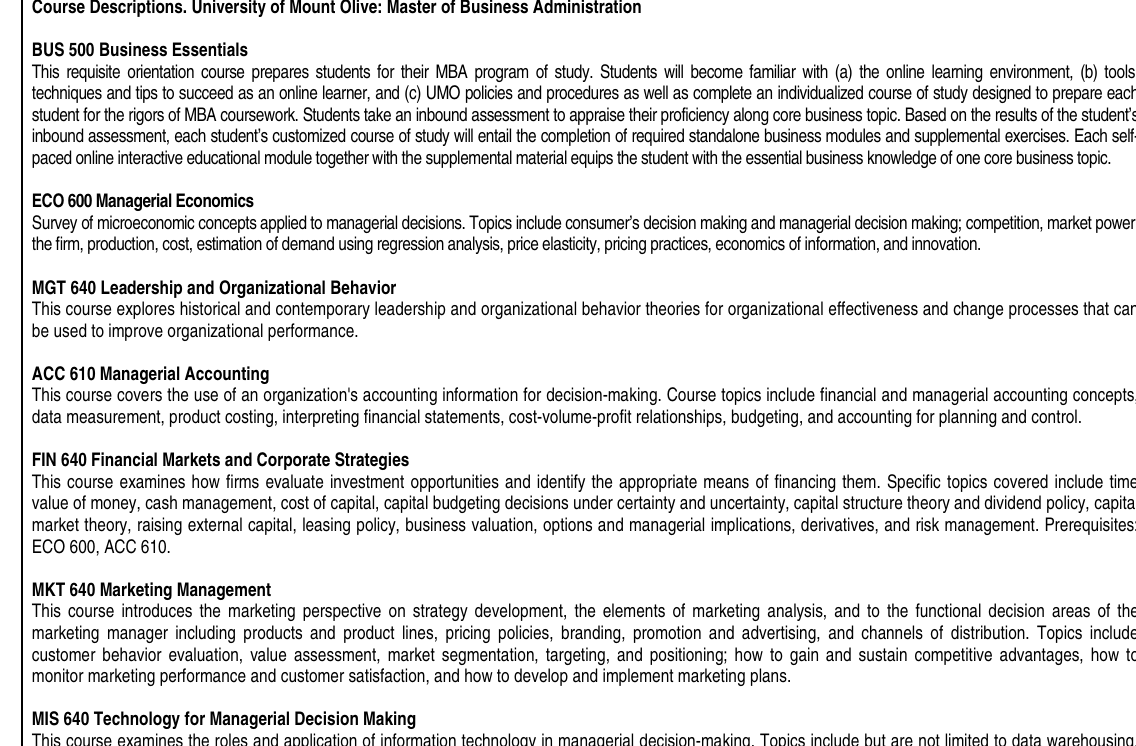
Table 3. MBA Degree Program Requirements. MBA Program of Study (30 semester